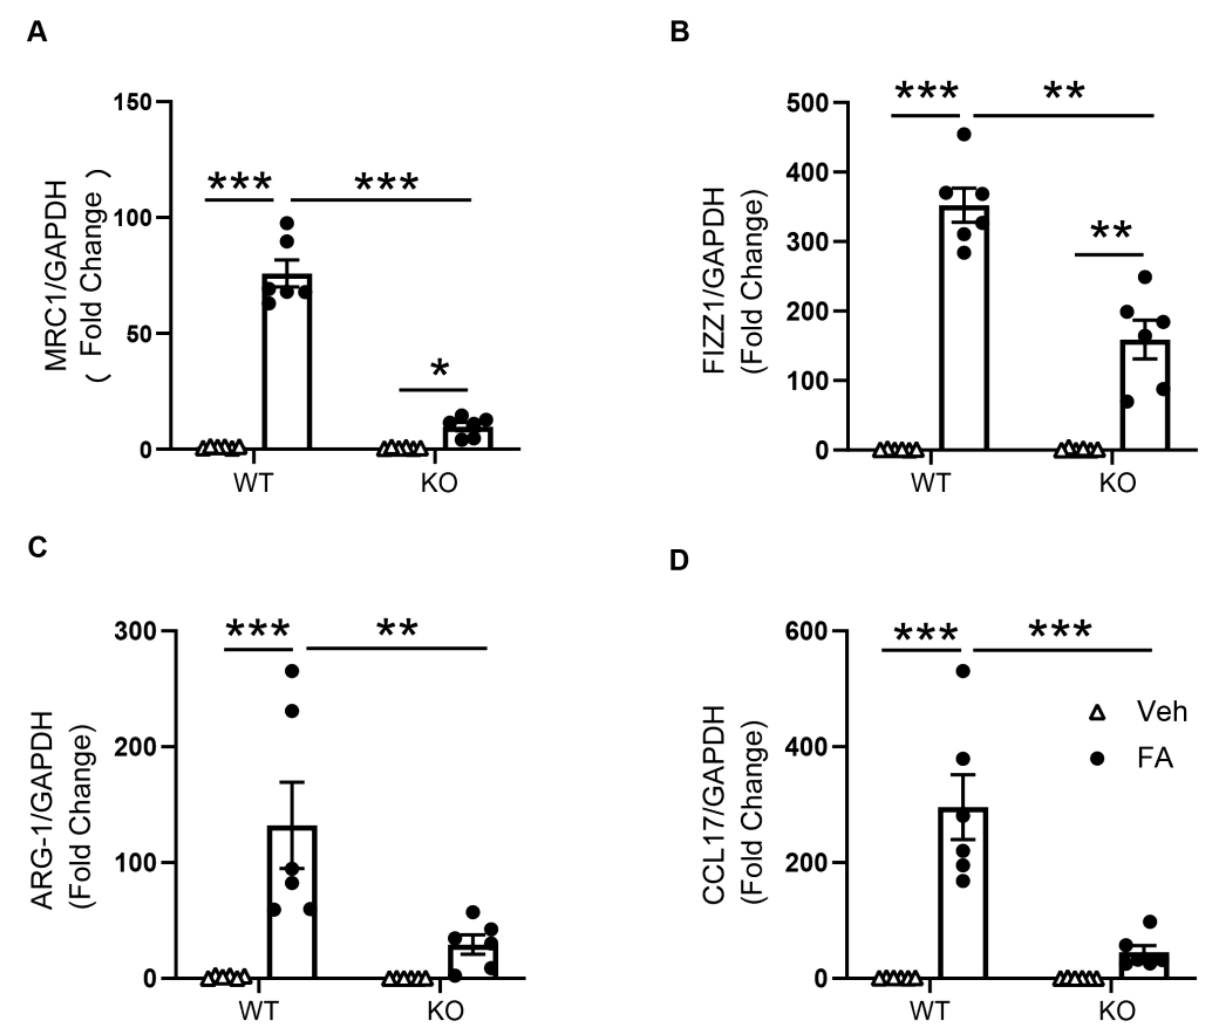
Figure 3. STAT6 deficiency inhibits M2 macrophage markers expression in the kidney. ( A ) Quantitative analysis of MRC1 mRNA expression in the kidneys of WT and STAT6 KO mice. *** p < 0.001; * p < 0.05. n = 6 per group. ( B ) Quantitative analysis of FIZZ1 mRNA expression in the kidneys of WT and STAT6 KO mice. *** p < 0.001; ** p < 0.01. n = 6 per group. ( C ) Quantitative analysis of ARG-1 mRNA expression in the kidneys of WT and STAT6 KO mice. *** p < 0.001; ** p < 0.01. n = 6 per group. ( D ) Quantitative analysis of FIZZ1 mRNA expression in the kidneys of WT and STAT6 KO mice. *** p < 0.001. n = 6 per group.